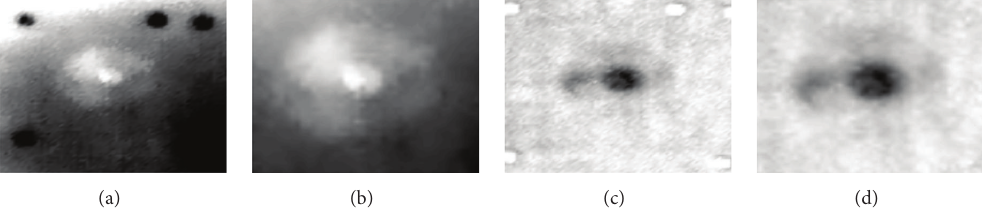
Figure 11: Results of the data registration process: IRT exemplary results (a) before and (b) after the registration process, THz exemplary results (c) before and (d) after the registration process; dpi before registration process, 40 (IRT) and 25 (THz), and after,